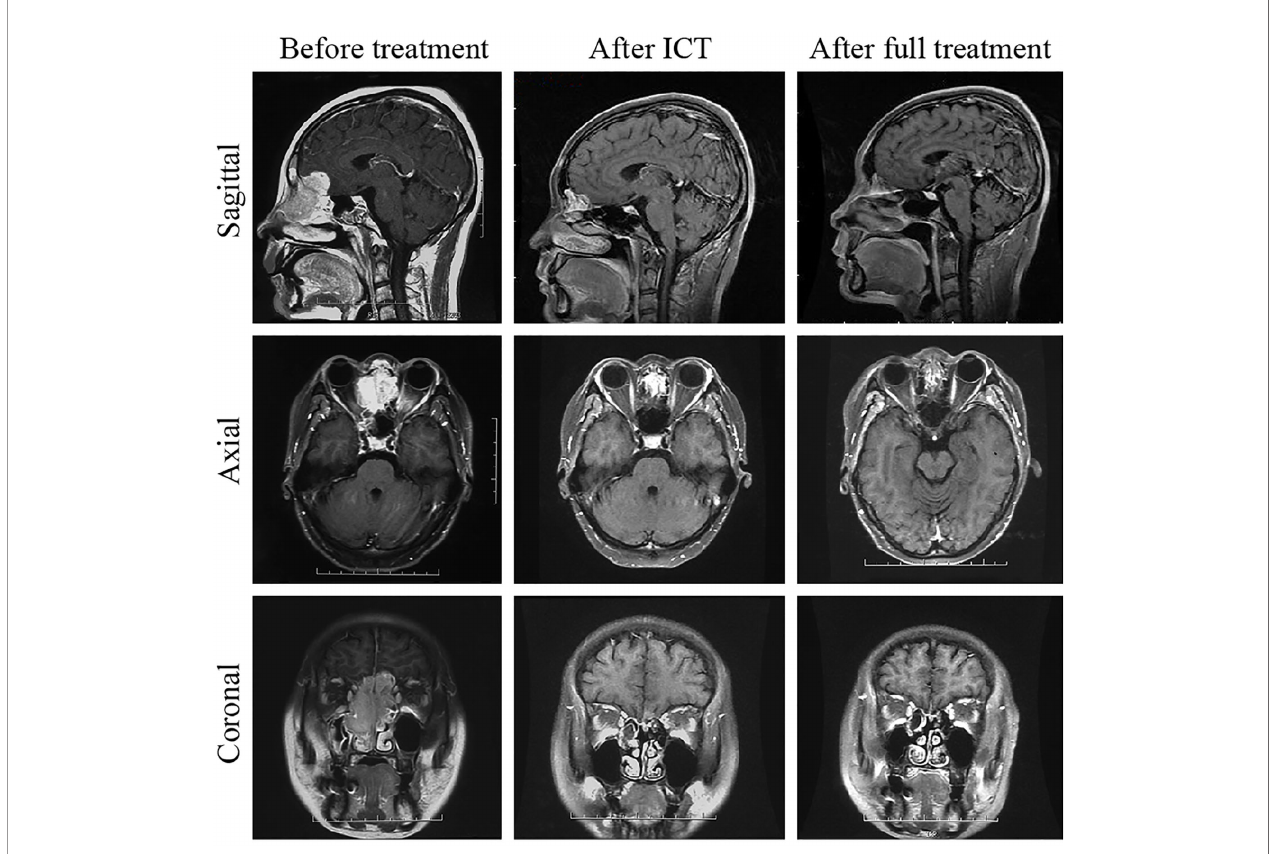
FIGURE 2 | Comparison of MRI results before and after treatment of one patient with neuroendocrine carcinoma. One month after the treatment, the tumor had completely subsided. The patient was followed up for 54 months and remained free of